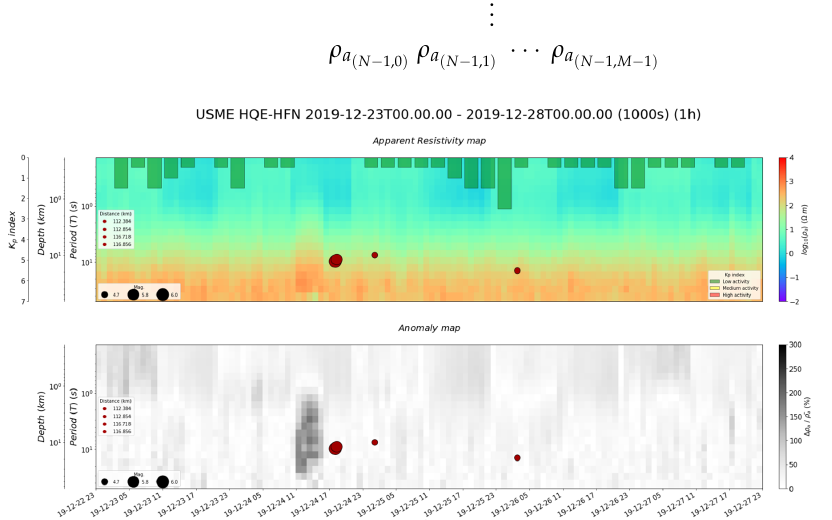
Figure 5. Anomaly registered before the 6.0 Mw Mesetas earthquake calculating the apparent resistivity from USME HQE-HFN channels. (Format of digitized data on the time axis: year-month-day hour).